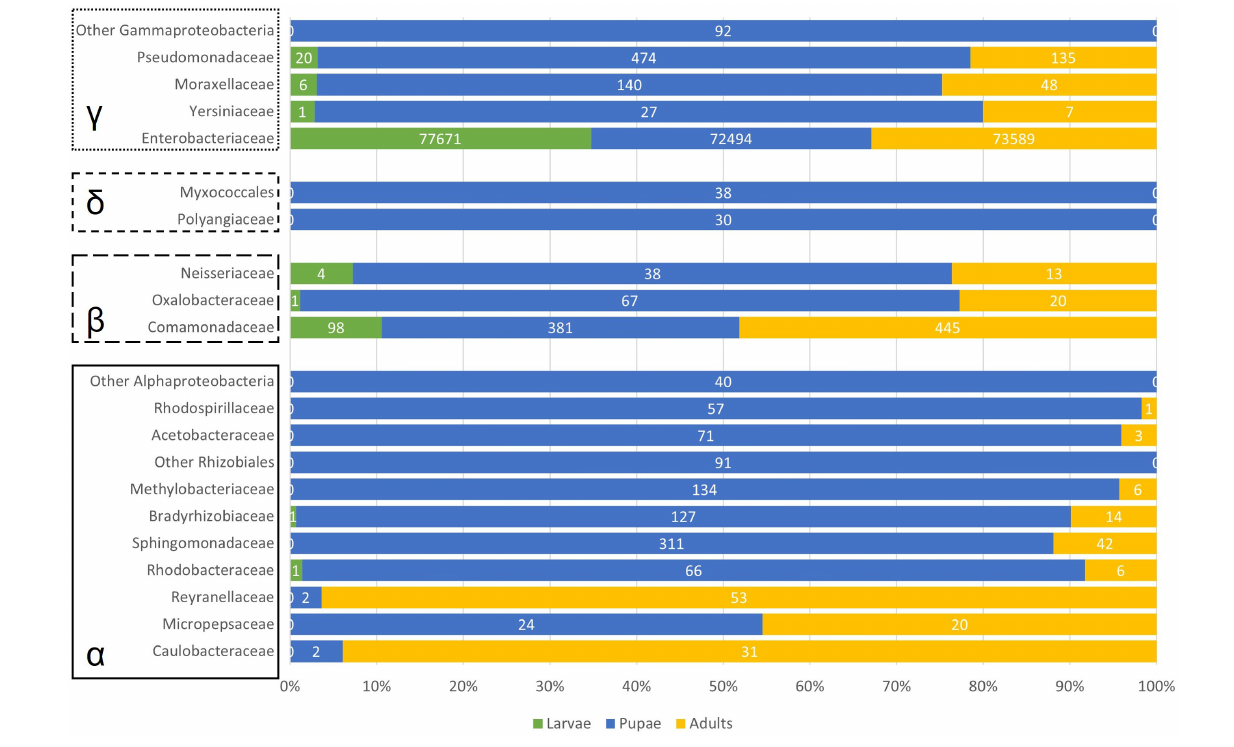
FIGURE 6 | Barplot of number of reads considering the represented Proteobacteria. α – 493 Alphaproteobacteria; β – Betaproteobacteria; δ – Deltaproteobacteria; γ –